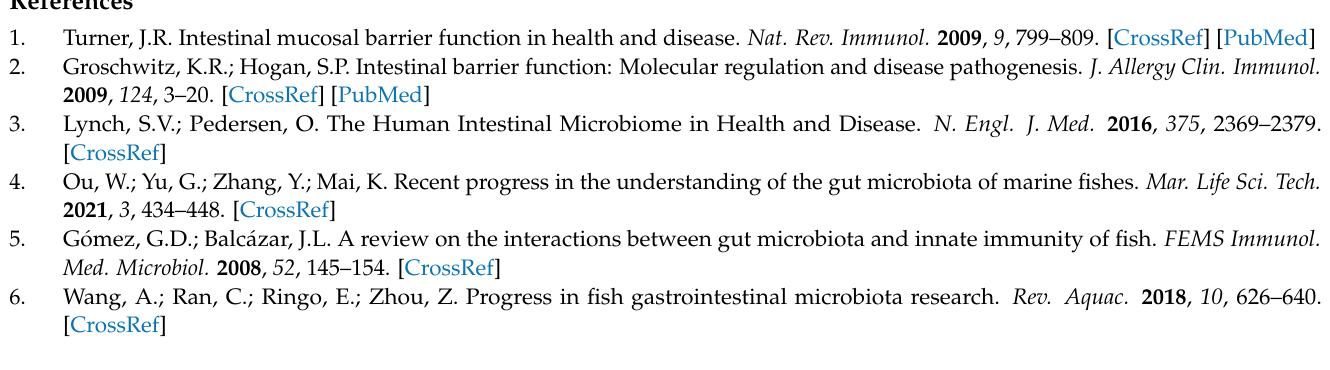
Table S2: AMOVA test of distal